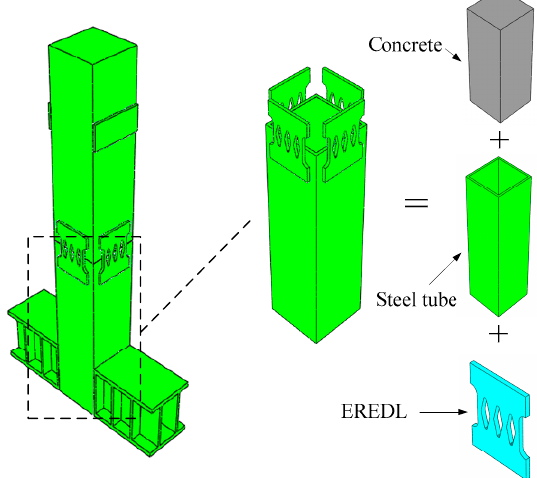
Figure 5. Finite element model of precast assembled pier.